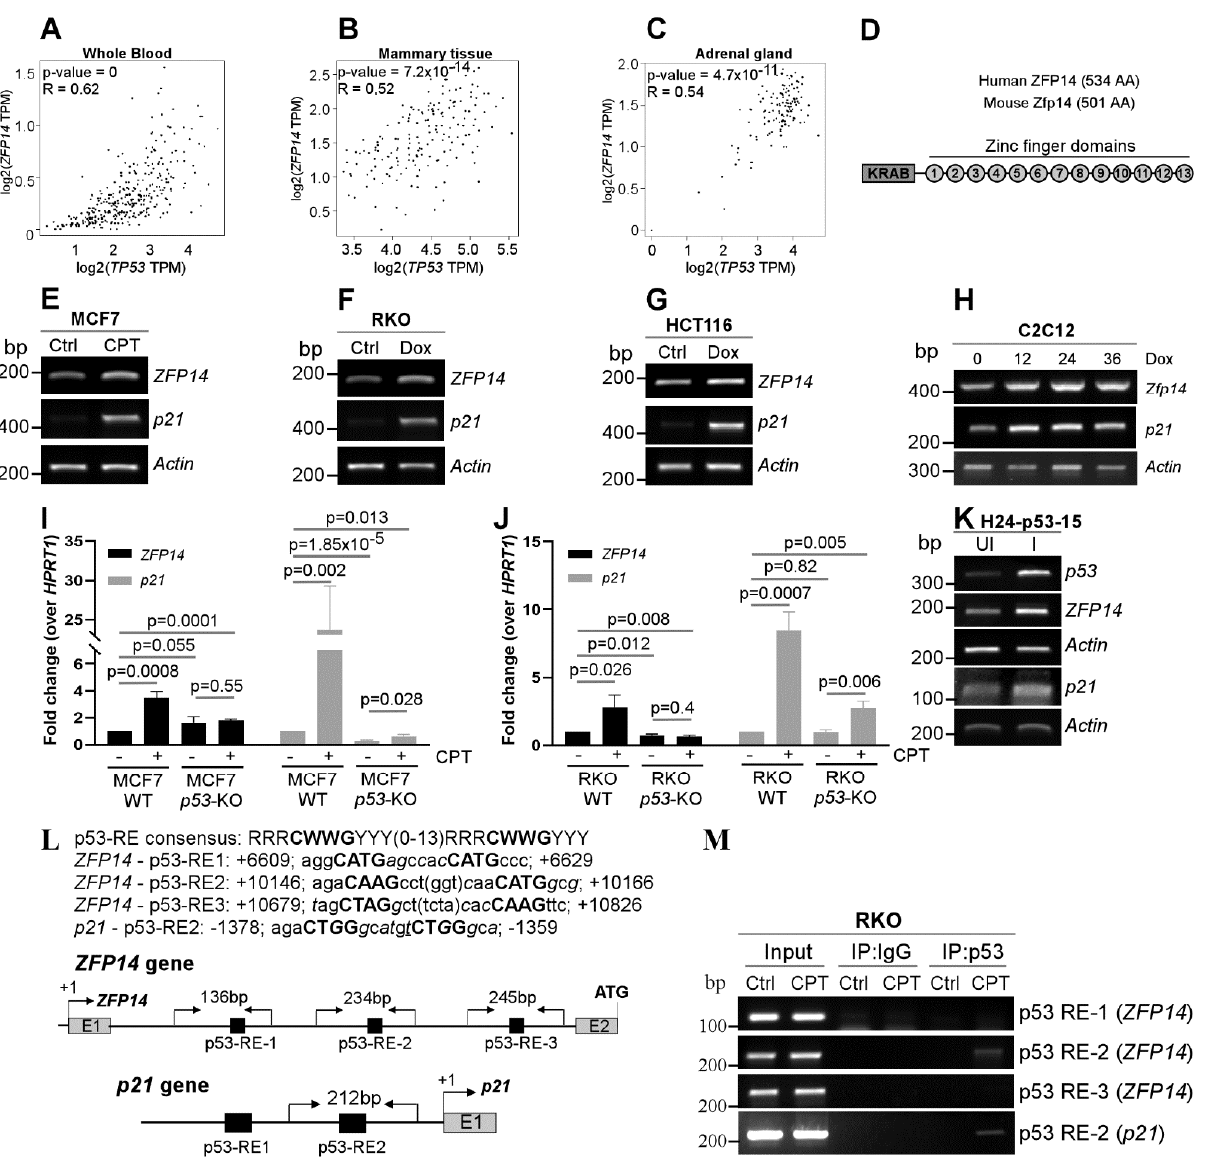
Figure 1. ZFP14 is induced upon DNA damage and is a p53 target. ( A – C ) Correlation of ZFP14 expression with p53 expression in normal human tissues from GEPIA. ( D ) Schematic showing the various domains and motifs present in human and mouse ZFP14. AA; amino acids. ( E – G ) The levels of ZFP14 , p21 and Actin mRNAs were measured by RT-PCR in MCF7 cells mock-treated or treated with 250 nM CPT ( E ) or RKO cells ( F ) and HCT116 cells ( G ) mock-treated or treated with 250 µ g/mL Dox for 18 h. ( H ) The levels of Zfp14 , p21 and Actin transcripts were measured in mouse C2C12 cells mock-treated or treated with 250 µ g/mL Dox for 12-36 h. ( I , J ) qRT-PCR was used to measure the levels of ZFP14 and p21 mRNAs in MCF7 WT or p53-KO cells mock-treated or treated with 250 nM CPT ( I ) and RKO WT or p53-KO cells mock-treated or treated 350 µ g/mL Dox for 18 h ( J ). ( K ) The levels of p53 , ZFP14 , p21 and Actin mRNAs were measured by RT-PCR in H1299 cells (H24-p53-15 clone) uninduced or induced to express p53 for 24 h. ( L ) Sequences of consensus p53-RE, the putative p53-REs located in ZFP14 intron 1 and p53-RE2 in the p21 promoter. Also shown are the locations of the p53-REs in the human ZFP14 and human p21 gene regions and the primer locations used for chromatin immunoprecipitation (ChIP) assays. ( M ) RKO cells were treated with 250 nM CPT for 16 h and the lysates obtained were used to perform ChIP assays using p53 antibody. PCR was performed using primers shown in ( L ) to determine the p53 binding to the ZFP14 promoter region. p53 binding to the p21 promoter upon DNA damage was used as a positive